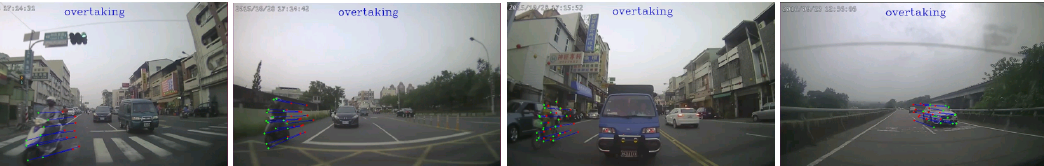
( a ) The overtaking detection results of city traffic scenes.